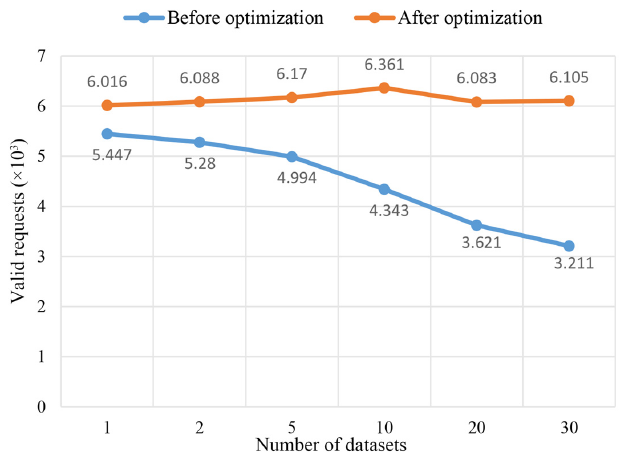
Figure 10. Comparison of total tile requests.